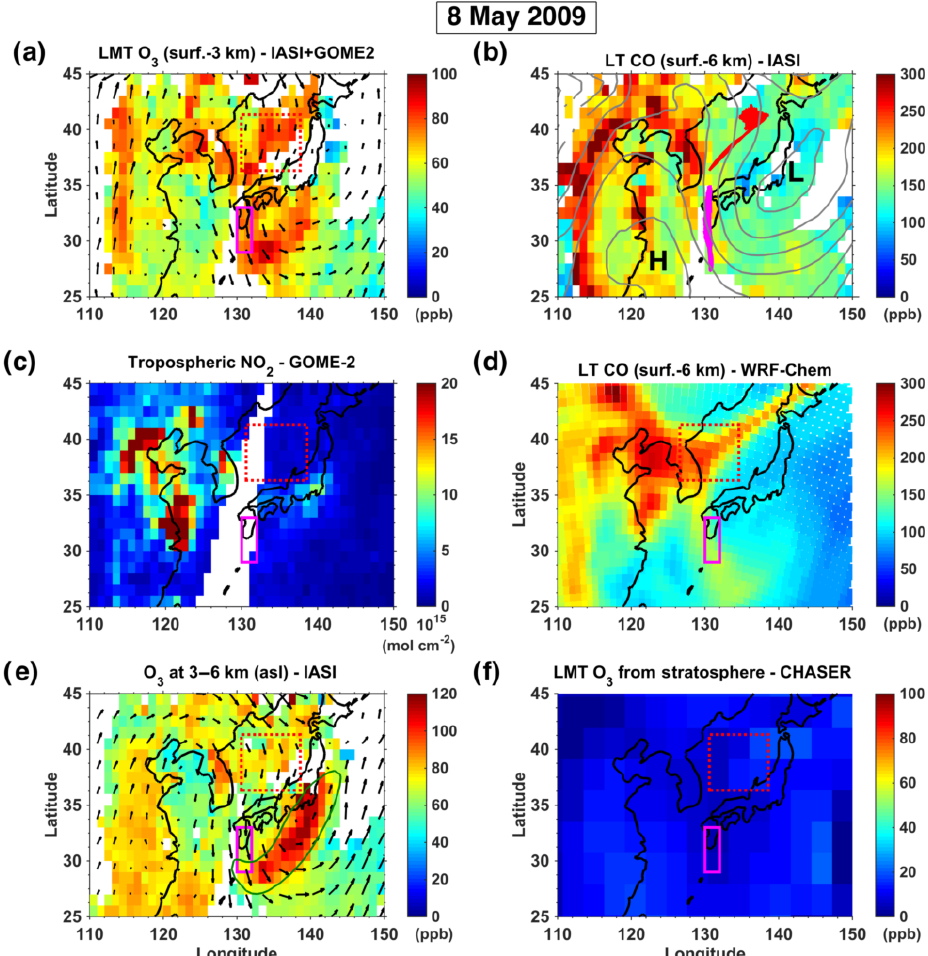
Figure 11. Same as Fig. 10 but for 8 May